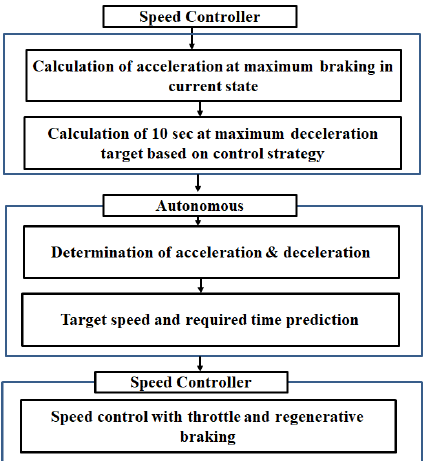
Figure 11. Regenerative braking control strategy with backpropagation method).